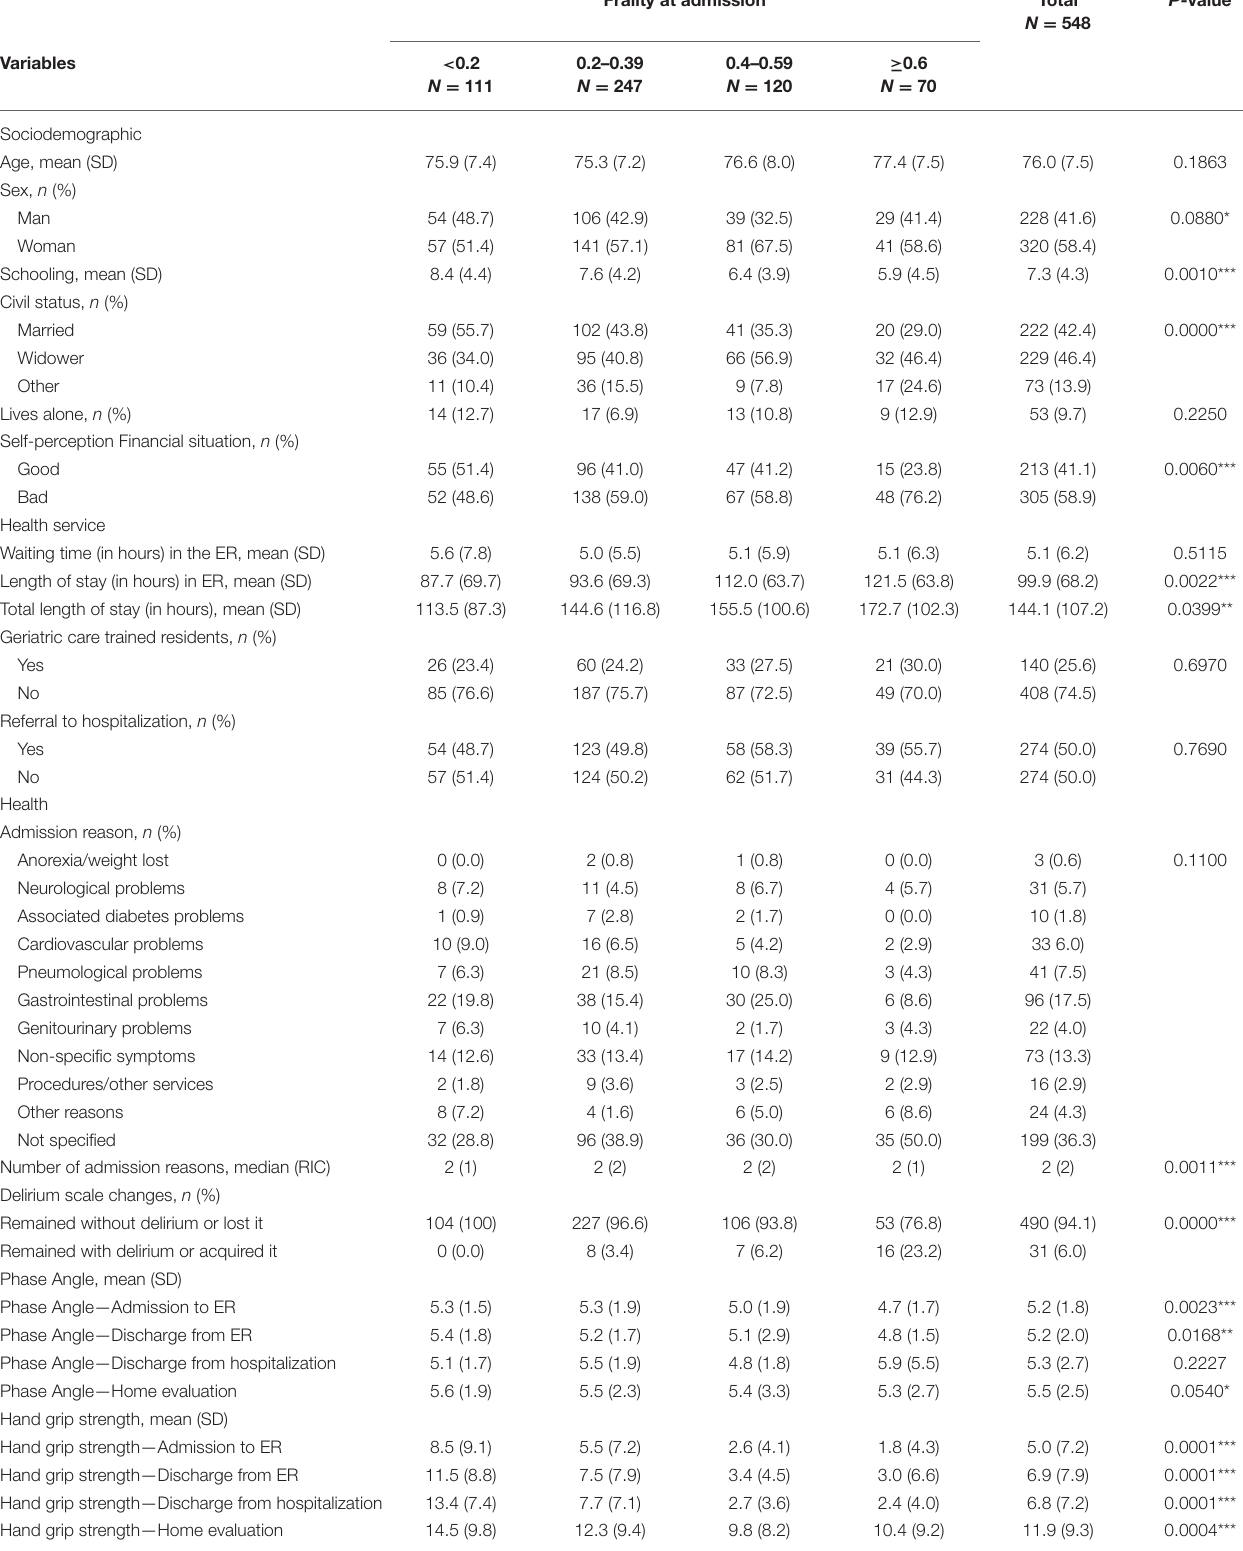
TABLE 1 | Sociodemographic characteristics of the studied individuals by frailty